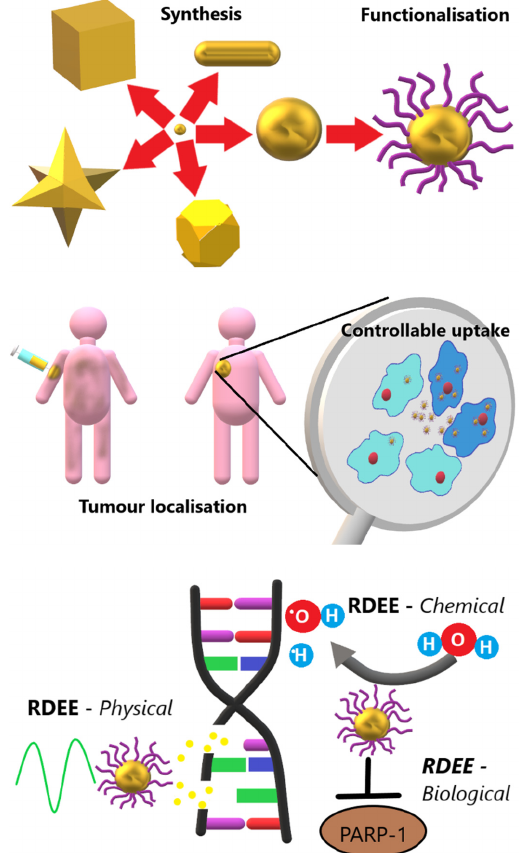
Figure 1. Visual summary of the advantages of AuNPs for delivering RDEE therapeutically. Synthesis: There are multiple shapes that can be synthesised readily and with rudimentary lab supplies. Functionalisation: A range of ligands can be readily attached in combination using click chemistry. Tumour localisation: AuNPs administered intravenously can accumulate preferentially at the site of a tumour. Controllable uptake: AuNPs can be functionalised to enter cancerous cells (darker blue) preferentially, and even targeted to organelles such as the nucleus (red spheres) once internalised. RDEE: Radiotherapy dose-enhancement effects can be delivered by physical (secondary electron generation), chemical (catalytic ROS generation), and biological (DNA repair inhibition) mechanisms. Adapted with permission from ref. [32]. Copyright 2021 The Institute of Cancer Research.